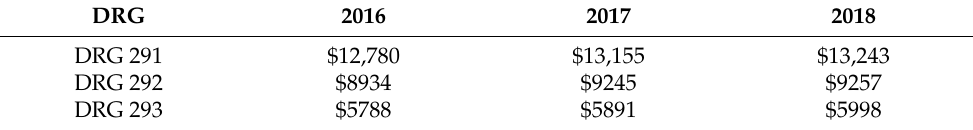
Table 3. Estimated total costs for heart failure by DRG in thousands, linear extrapolation method.